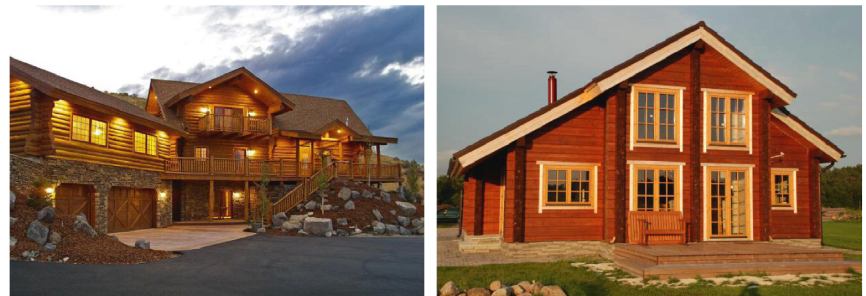
Figure 1: Examples of log-haus